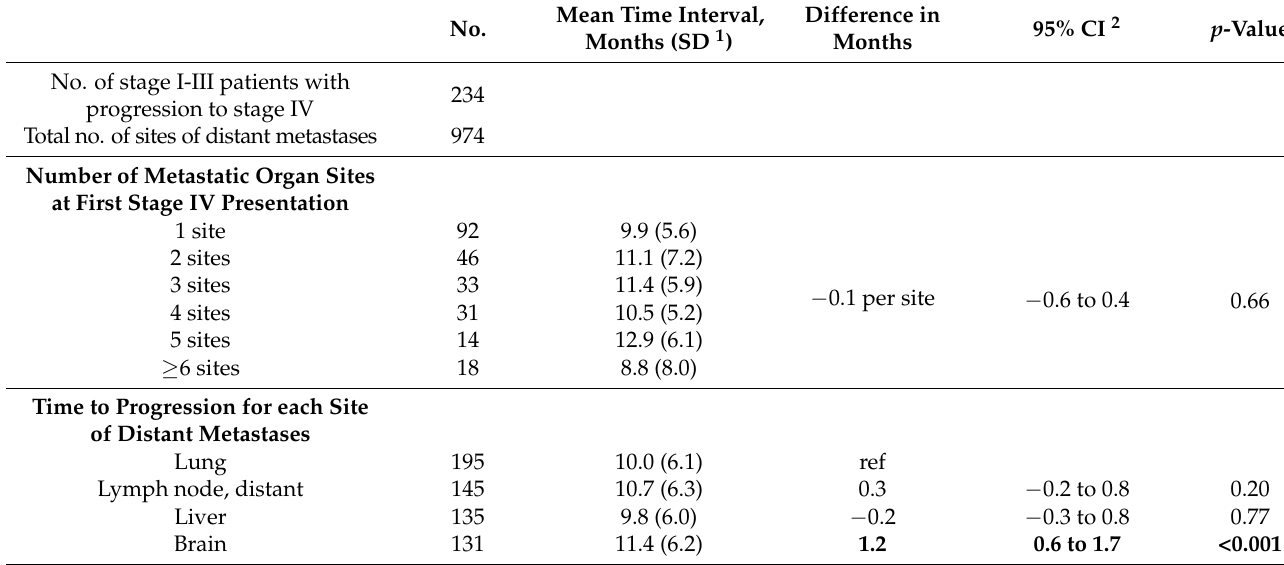
Table 4. The mean time interval from diagnosis of primary melanoma to progression to first stage IV presentation related to the number of sites and the localisation of metastases of patients diagnosed with a single stage I-III primary melanoma between July 2017 and December